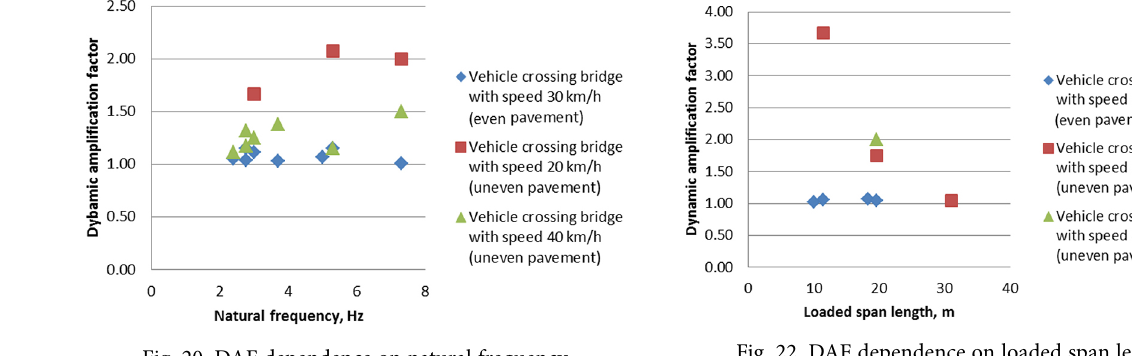
Fig. 20. DAF dependence on natural frequency